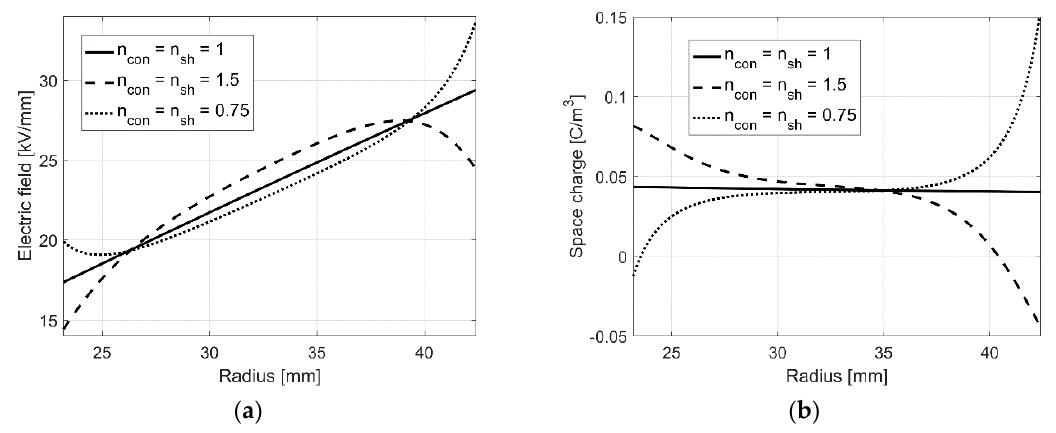
Figure 14. ( a ) Example of the stationary electric field within a MI insulation, considering additional charge accumulation at both electrodes; ( b ) corresponding space charge distribution [70].